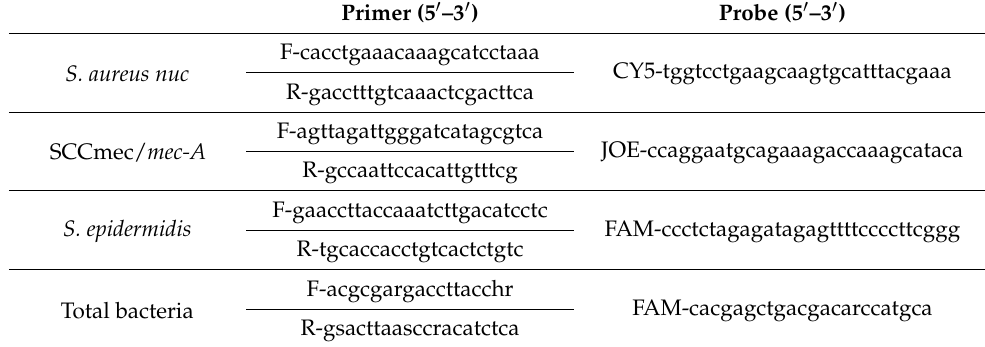
Table 4. Oligonucleotide sequences for real-time PCR. Primer (5 (cid:48) –3 (cid:48)